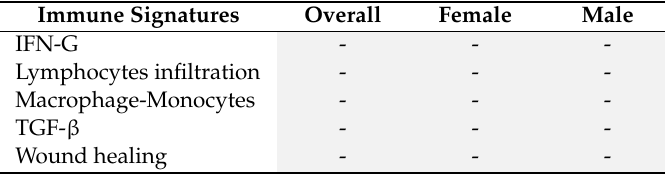
Table 3. Lack of prognostic value of immune signature expression in LUSC patients. Immune